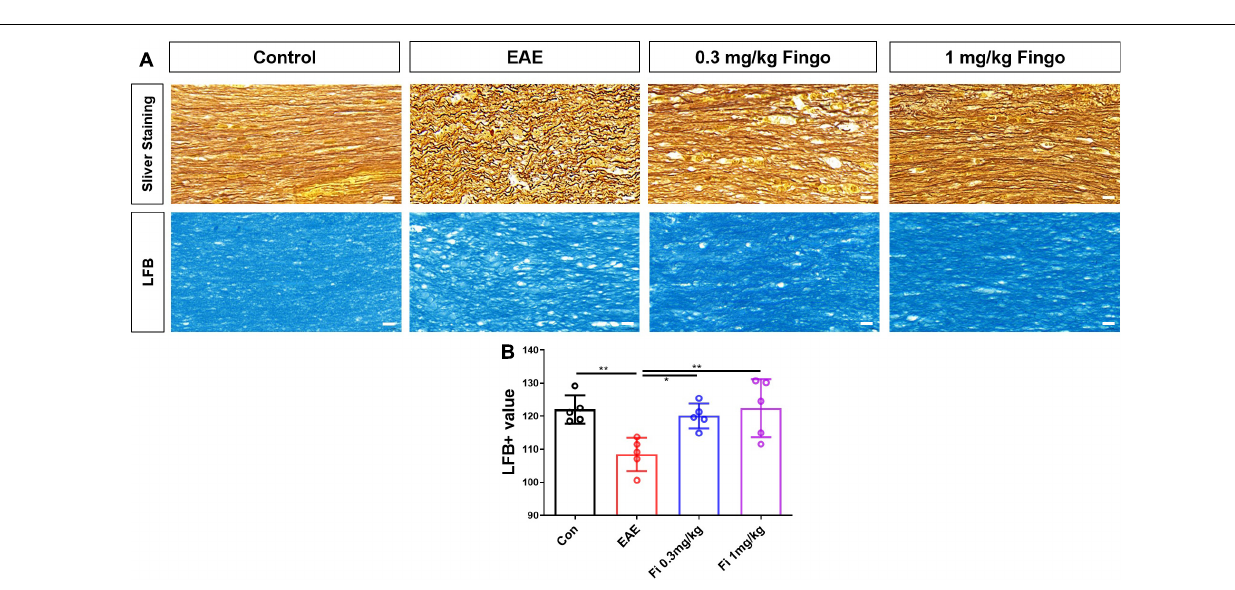
FIGURE 3 | Demyelination and axon degeneration in the optic nerve with fingolimod treatment. (A) Axons and myelin in the optic nerve were marked with sliver staining and LFB. (B) Demyelination analyzed by LFB scores in the optic nerve (mean gray value). Values are presented as mean ± SD. One-way ANOVA plus Turkey’s multiple comparisons. * P < 0.05, ** P < 0.01, *** P < 0.001. Scale bar = 10 µ